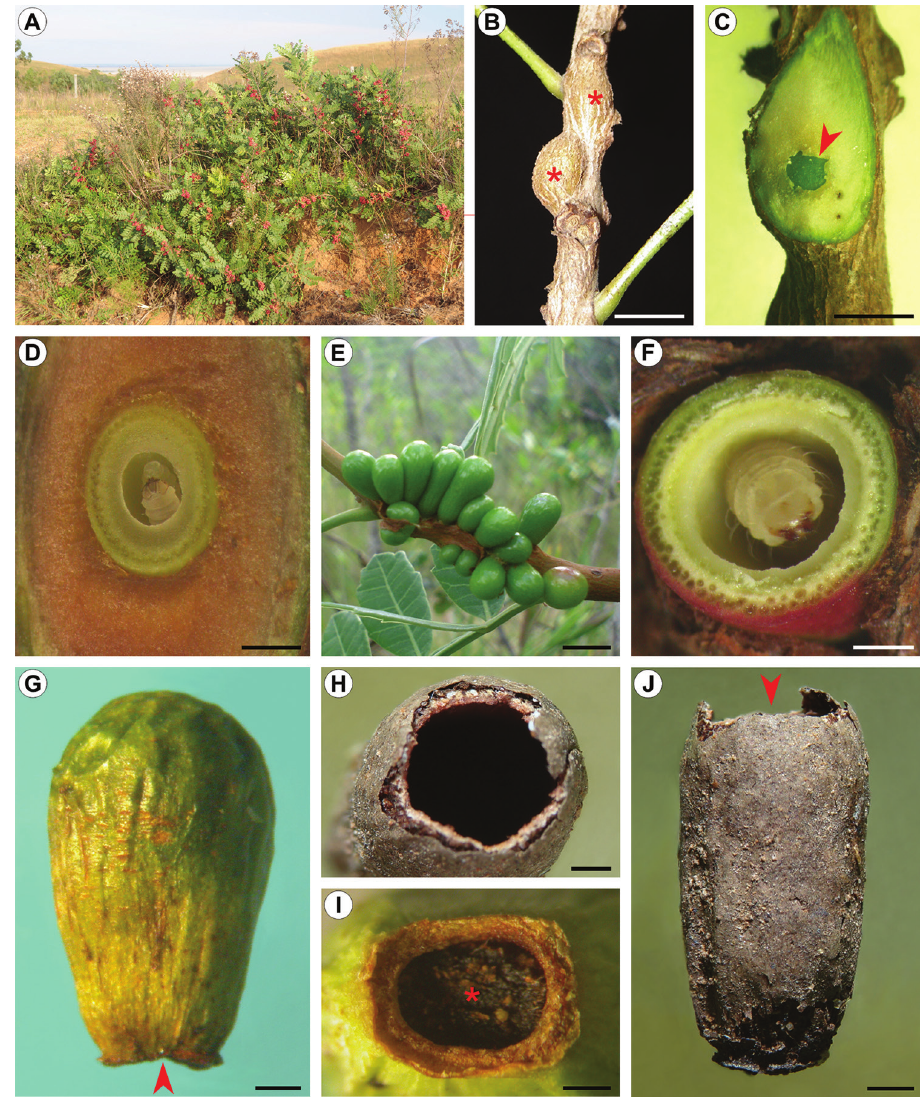
Figure 9. Natural history of C. pampeanus on S. weinmannifolius . A host plant patch at the type locality; B young developing galls within swollen stems (asterisks); C dissected swollen stem showing developing gall inside (indicated by arrow); D transversally sectioned young gall showing second instar larva inside; E group of external developing galls on branch; F transversally sectioned, full grown gall, showing last instar larva inside; G young dehiscent gall; H detail of emergence orifice left by adult on distal portion of old, empty gall (pointed by arrow in J ); I detail of young dehiscent gall (arrow in G ), showing orifice clogged by larval feces (asterisk); J old, empty, overwintered gall. Scale bars: 2 mm ( B ); 1 mm ( C, F, G, H, I, J ); 0.5 mm ( D ); 5 mm ( E